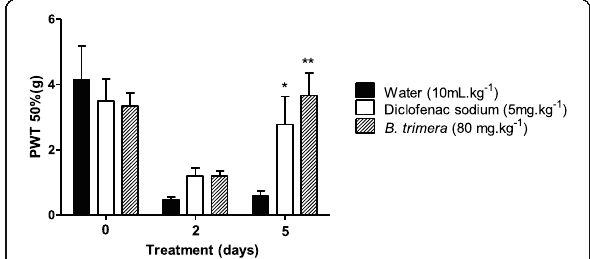
Fig. 5 Antinociceptive effects of an oral administration of the B. trimera aqueous extract on mechanical allodynia induced by FCA (i.pl.). Each bar represents the mean±standard error of 6 – 9 mice. * p <0.05 or ** p <0.01 represents the level of significance when compared to the water-treated animals (Two-Way ANOVA, followed by the Bonferroni